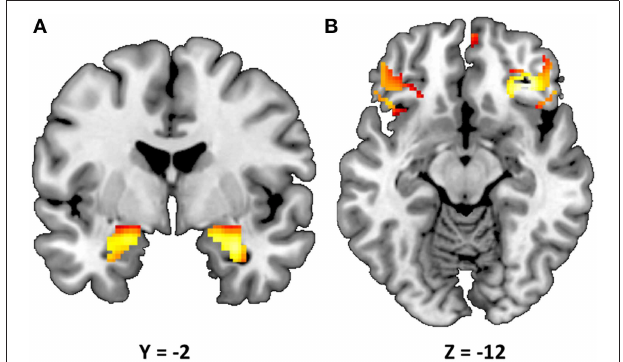
FIGURE 1 | Statistical parametric map illustrating mean bilateral activity for the Faces > Shapes contrast. Activation clusters are presented for (A) the amygdala (peak voxel activation in the left hemisphere: x = − 22 , y = − 6 , z = − 18 , t = 28 . 55 , p < 0 . 000001 , kE = 179; right hemisphere: x = 28 , y = − 4 , z = − 20 , t = 32 . 82 , p < 0 . 000001 , kE = 199 ) and (B) Brodmann areas 11 and 47 (peak voxel activation in the left hemisphere: x = 58 , y = 28 , z = 0 , t = 15 . 60 , p < 0 . 000001 , kE = 143; right hemisphere: x = − 52 , y = 40 , z = − 2 , t = 14 . 47 , p < 0 . 000001 , kE = 24 ). The clusters are overlaid onto canonical structural brain images in the coronal plane ( y = − 2 ) and axial planes ( z = − 12 ), respectively.